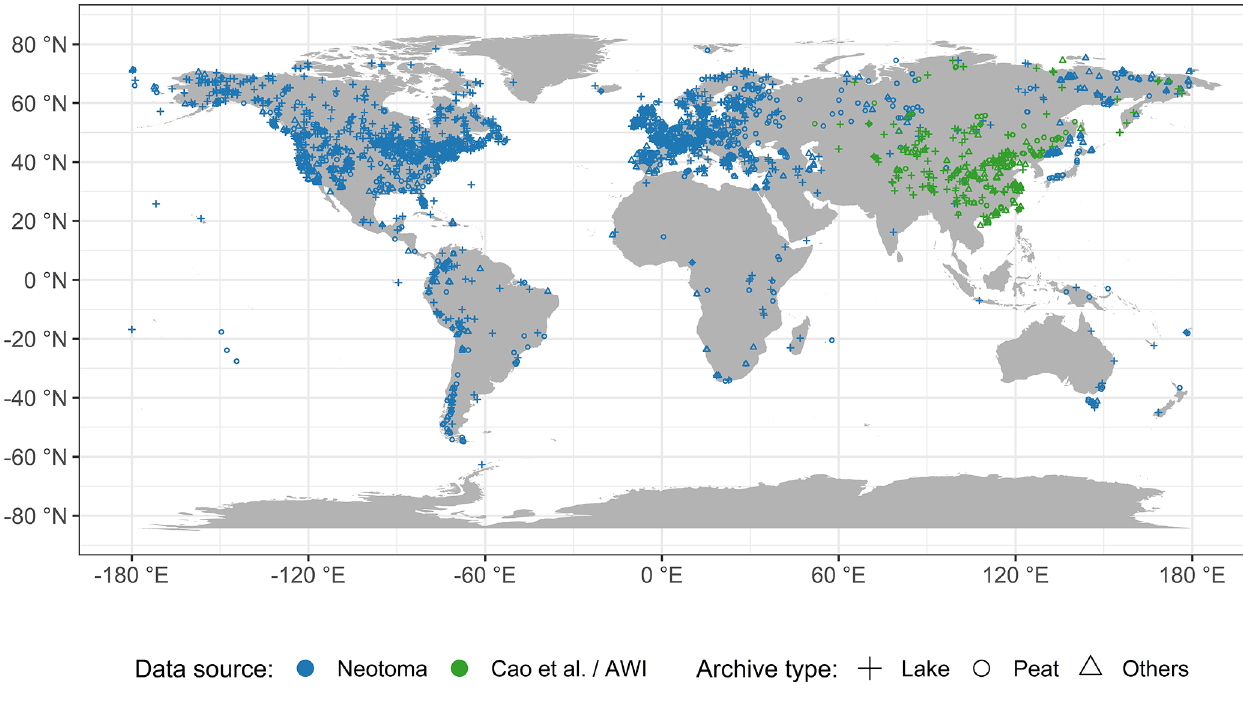
Figure 1. Map of records by source and archive